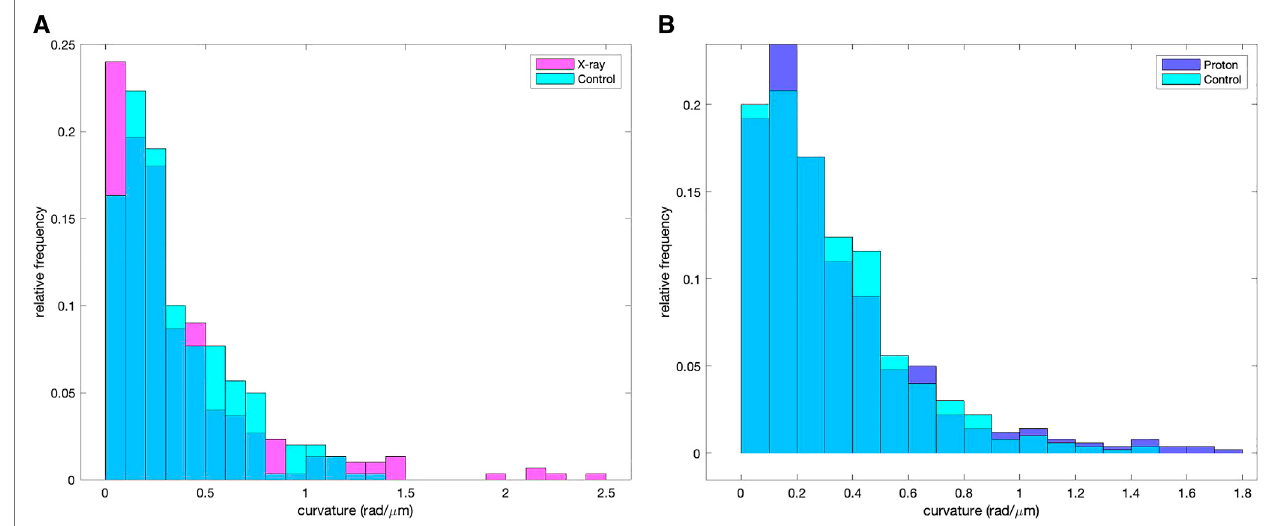
FIGURE5| PixelwisecurvaturedistributionofthereconstructedMTsofthecontrolandtheproton-irradiatedsamples (A) .Relativepixelwisecurvaturedistributions of the reconstructed MTs of the control and X-ray irradiated samples (B) .